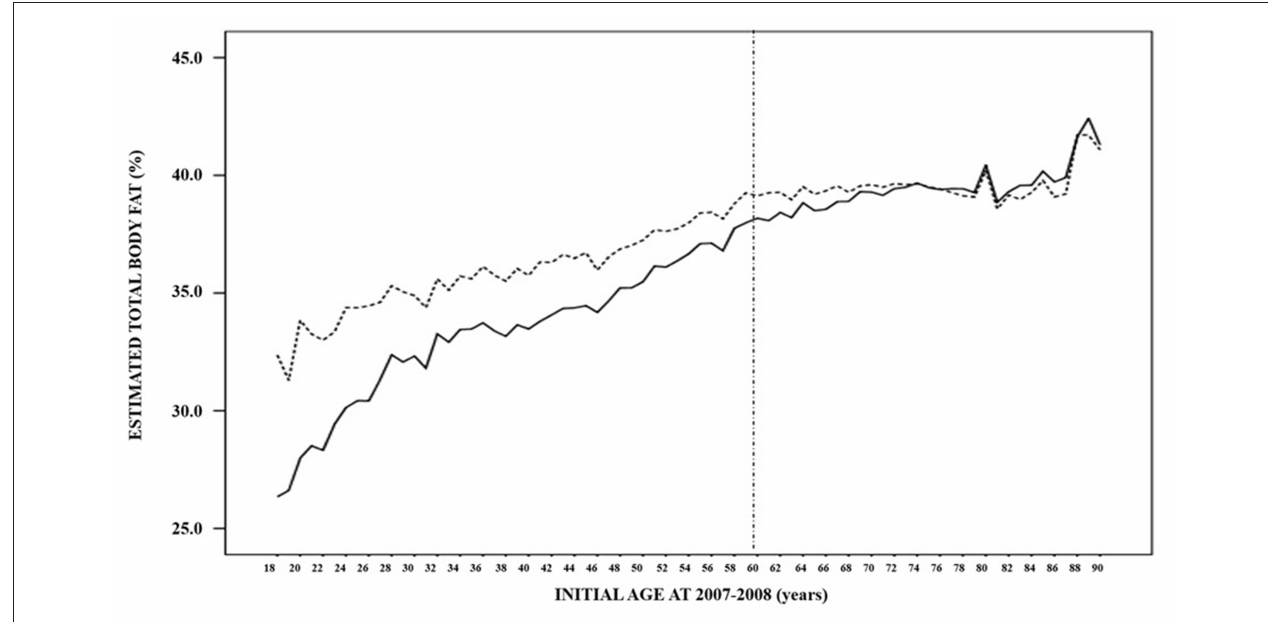
FIGURE 2 | Estimated mean total body fat distribution of the 50,019 subjects in the 2007–2008 (solid line) and 2017–2018 (dashed line) paired periods according to their age at the first